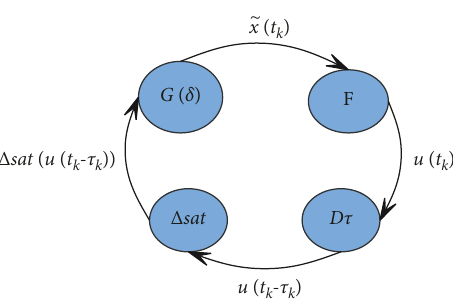
Figure 1: Feedback configuration of system